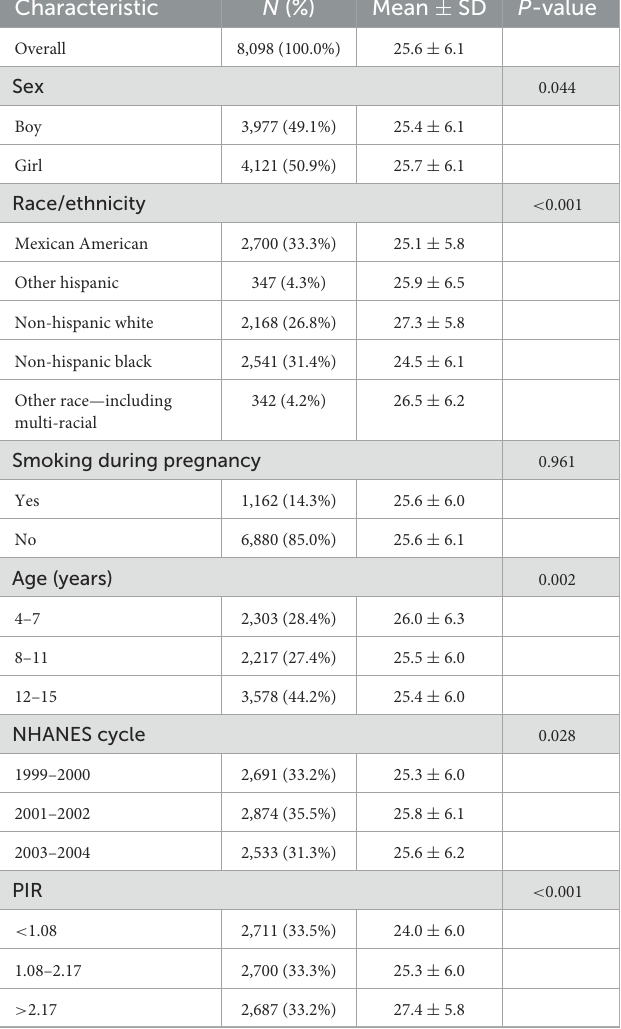
TABLE 2 Mean maternal age at childbirth based on outcomes for study participants ( n = 8,098). Neurodevelopmental